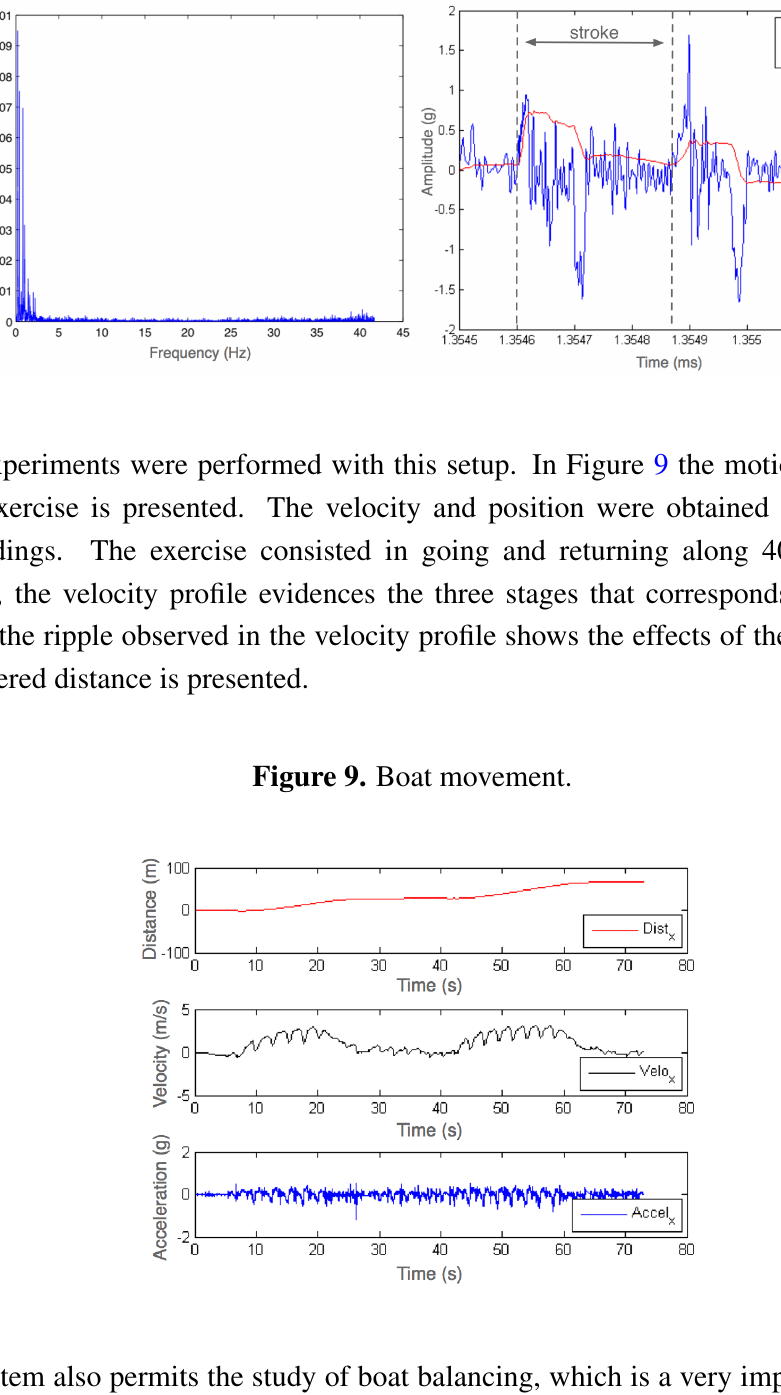
Figure 8. Left: Power spectra of the acceleration readings. Right: Acceleration and velocity time series.